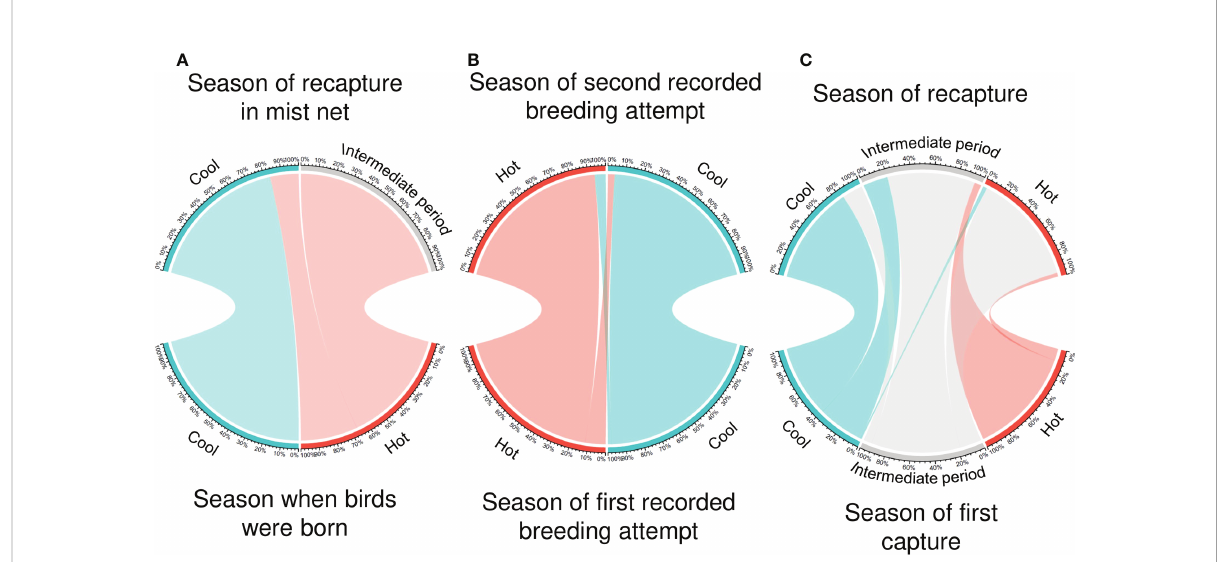
FIGURE 2 Chord diagrams assessing connectivity between hot and cool populations of the Cape Verde storm-petrel in Cima Islet (Cabo Verde). Hot season is depicted in orange, cool season in blue, and intermediate periods in grey. The bottom of the diagram shows the percentage of individuals that were initially captured in each season while the top shows the percentage of individuals during the period when they were recaptured for (A) birds ringed as chicks; (B) birds ringed as breeding adults and; (C) birds ringed in mist-nets. Sample sizes are summarized